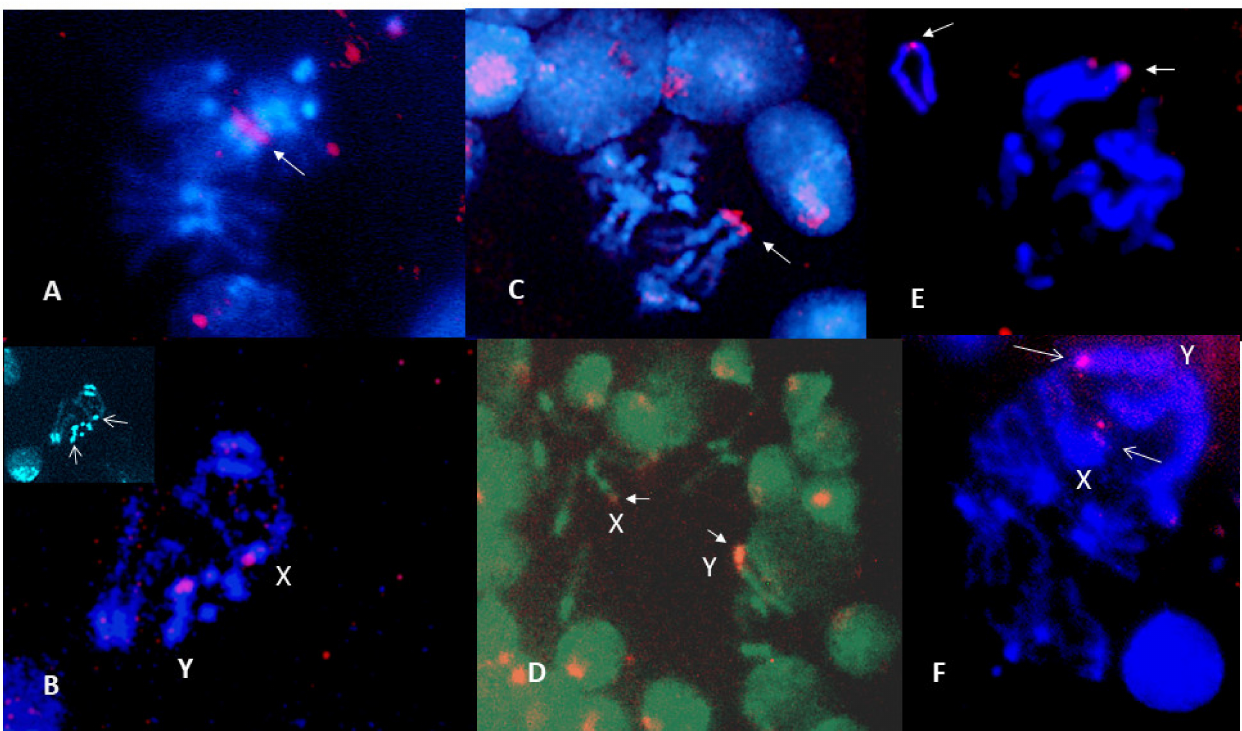
Figure 5. NOR sites shown by fluorescence in situ hybridization (FISH). Chromosomes stained with DAPI. ( A ) Scaptodrosophila xanthorrhoea female with NOR site on X chromosome (arrow). The rRNA technique was used. ( B ) Scaptodrosophila xanthorrhoea male with NOR sites on ends of X and Y chromosomes. Insert in upper left shows same photo with DAPI staining. Each chromosome or chromosome pair can be distinguished by the shape of its heterochromatin. Y (arrow) is completely heterochromatic. X has a single round heterochromatic end (arrow). An rDNA probe was used. ( C ) Scaptodrosophila cancellata female with NOR site at end of X chromosome heterochromatic arm (arrow). The rRNA technique was used. ( D ) Scaptodrosophila cancellata male set. Heterochromatic Y has NOR site at one end (arrow). X has pale NOR site at end of heterochromatic arm (arrow). An rDNA probe was used. ( E ) Scaptodrosophila sp. aff. cancellata female with site at end of heterochromatic arm of X (arrows). An rDNA probe was used. ( F ) Scaptodrosophila sp. cancellata male with strong site on heterochromatic Y chromosome (arrow) and weaker site at heterochromatic end of X (arrow). An rDNA probe was